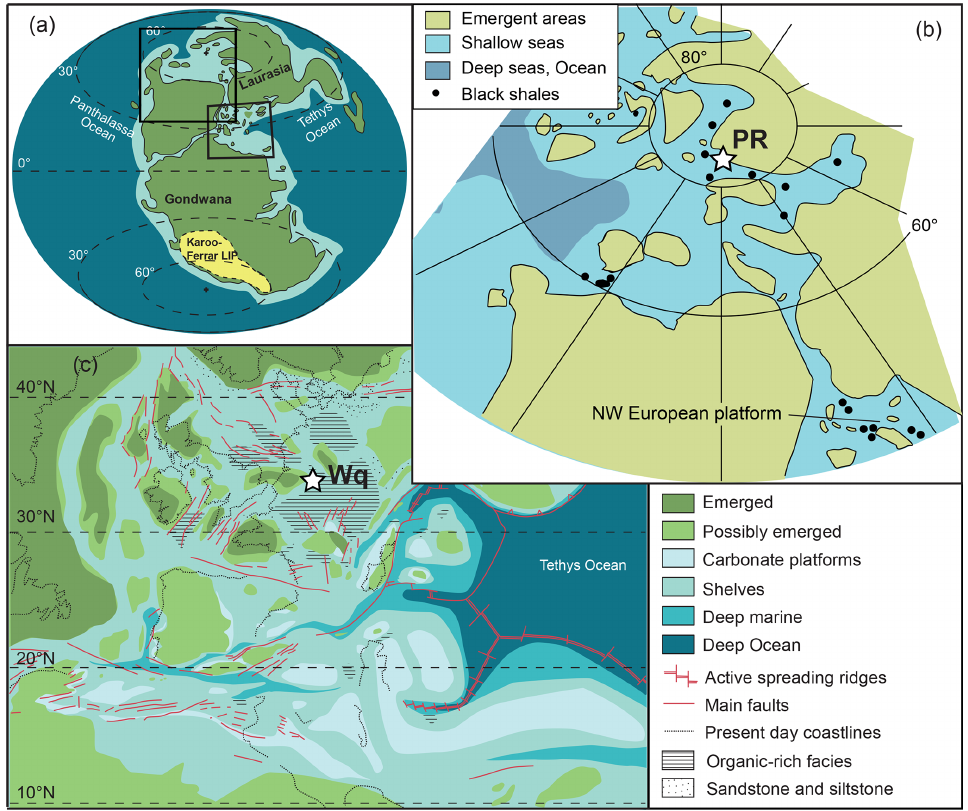
Figure 1. Location of the studied sites with regard to Toarcian (Early Jurassic) geography. (a) Global map modified from Dera et al. (2009). (b) Arctic map modified from Nikitenko and Mickey (2004). (c) Tethyan map modified from Thierry (2000). Localities: PR – Polovinnaya River; Wq –